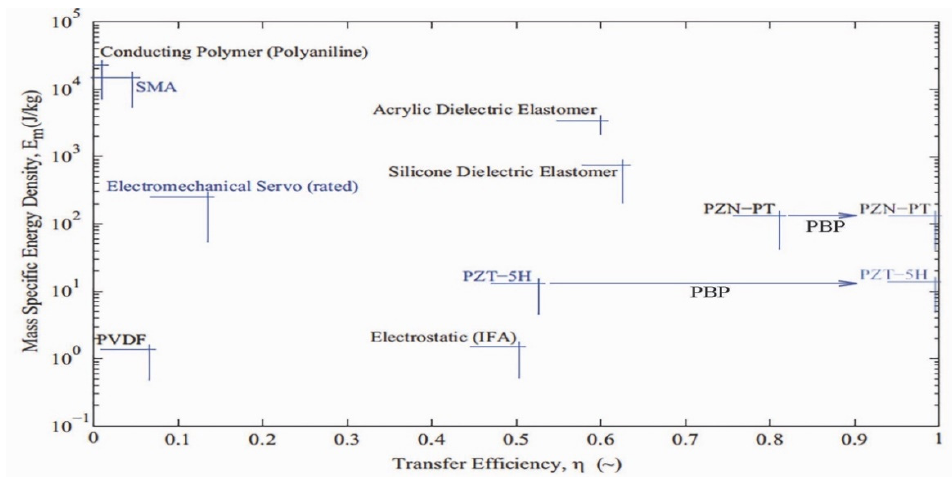
Figure 5. Primary Flight Control Actuator Classes and Transfer Efficiencies [22–28,32].